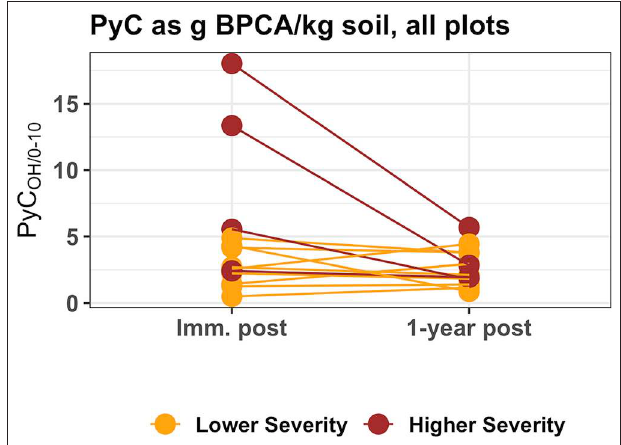
FIGURE 5 | A comparison of the soil mass normalized ratio of PyC in the O-horizon to PyC in the mineral soil (PyC OH / 0 − 10 ) at the immediate post-fire and 1-year post-fire time